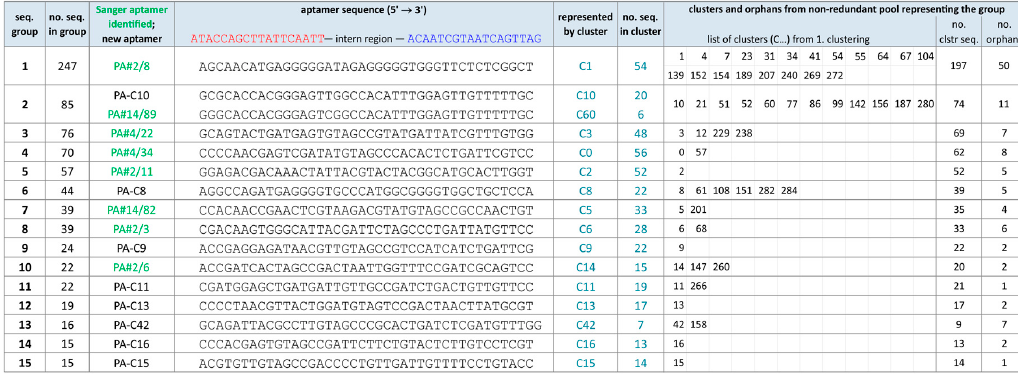
Figure 3. Identified sequence groups (size ≥ 15 seq.) from data analysis of the NGS pool by the two- step clustering and alignment method. All clusters coming from the non-redundant pool and the total number of orphans representing each group are